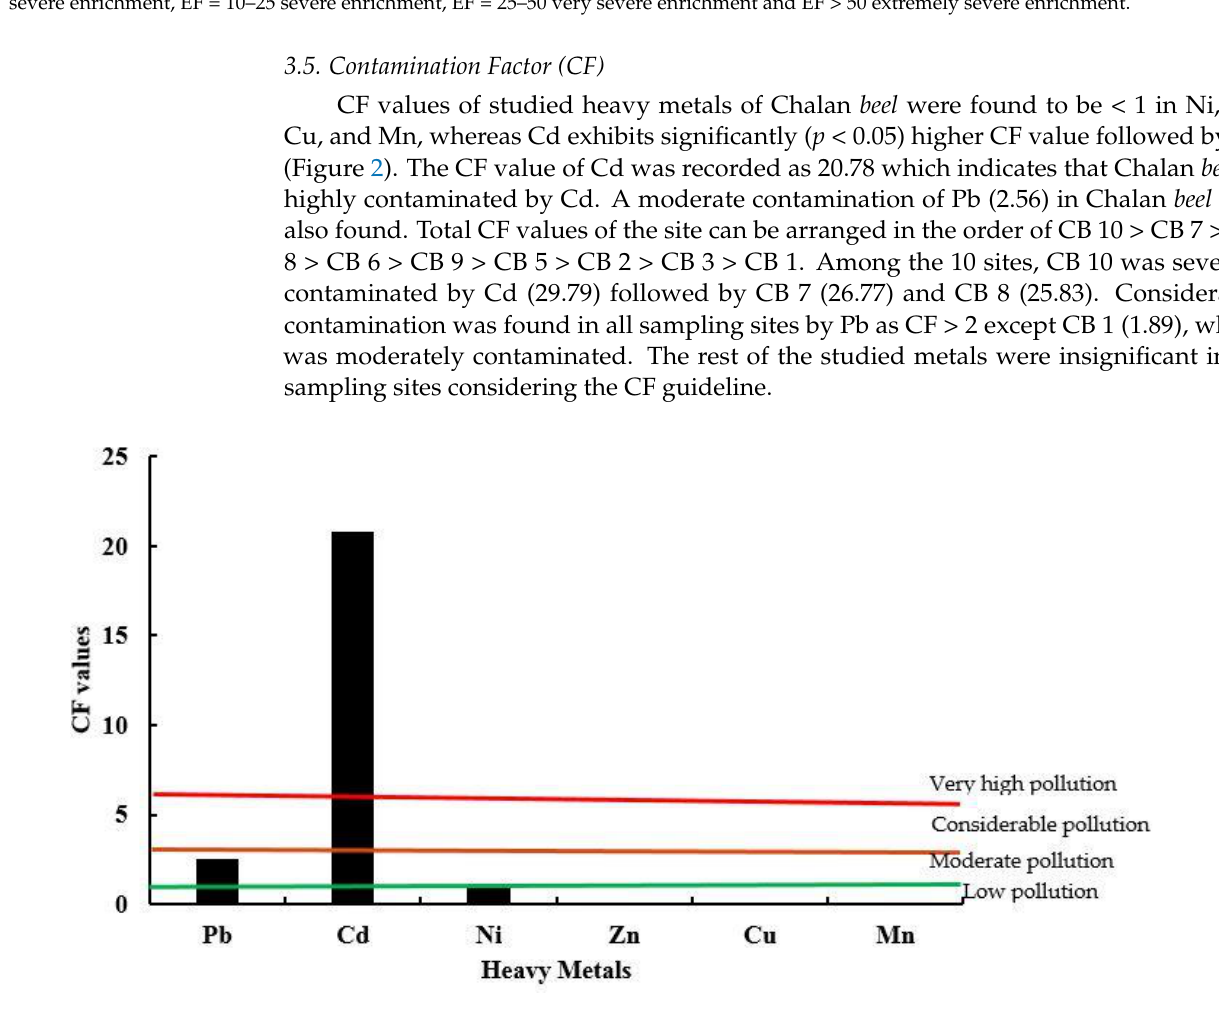
Figure 2. Contamination factors (CFs) for sediment samples in the study area. According to Turekian and Wedepohl [35] CFs were categorized as: low contamination: CF < 1; moderate contamination: 1 ≤ CF < 3; considerable contamination: 3 ≤ CF < 6 and very high contamination at CF > 6.